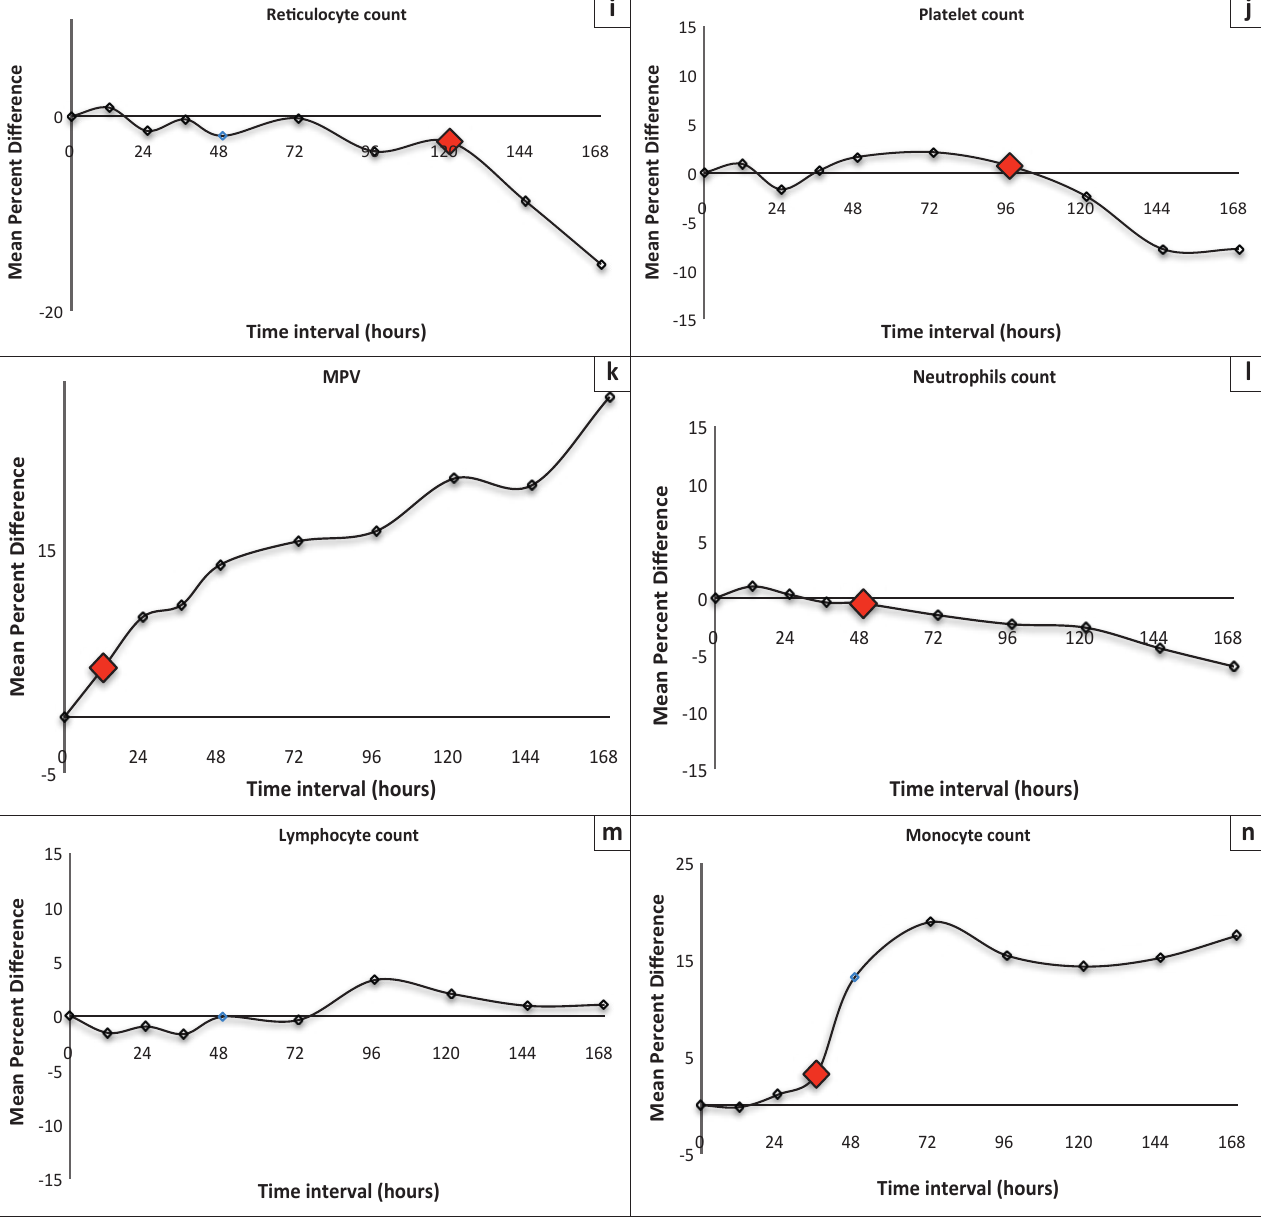
The mean percentage difference for full blood count, differential count and reticulocyte count was plotted against time in hours from the value at time zero. The number of specimens at 24, 96, 120, 144 and 168 hours after collection were 38, 35, 34, 34 and 27, respectively, owing to insufficient sample for analysis or partial aspiration failure. The stability of a parameter was defined in relation to the precision of the ADVIA® 120 analytical method. A parameter was considered stable when its difference was smaller than one coefficient of variation ( % ) of the assessed method. The red diamond indicates the maximum time point at which specimens were stable. FIGURE 2 (Continues...): Stability analysis (mean percent difference) at 4 °C – 8